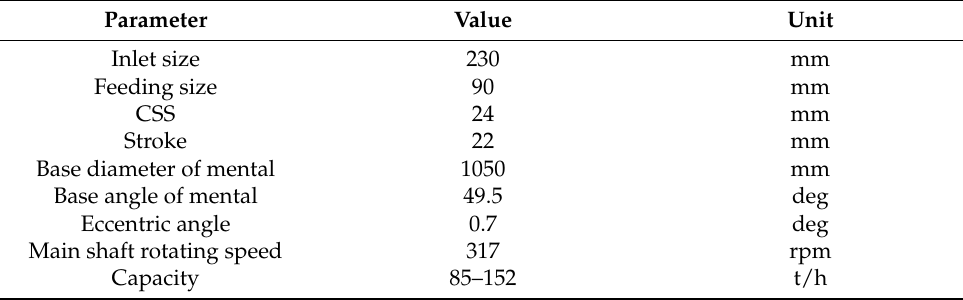
Table 3. The structural and operating parameters of the CF11 hydraulic cone crusher.